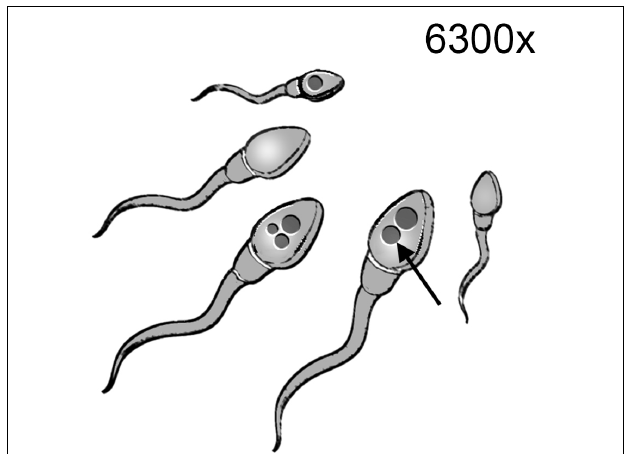
FIGURE 3 | Intracytoplasmic morphologically selected sperm injection (IMSI). Spermatozoa are examined under a magnification system of 6300x in order to discriminate those spermatozoa lacking vacuoles (arrow) and showing normal morphology. These spermatozoa are collected with the micromanipulation system for their use in